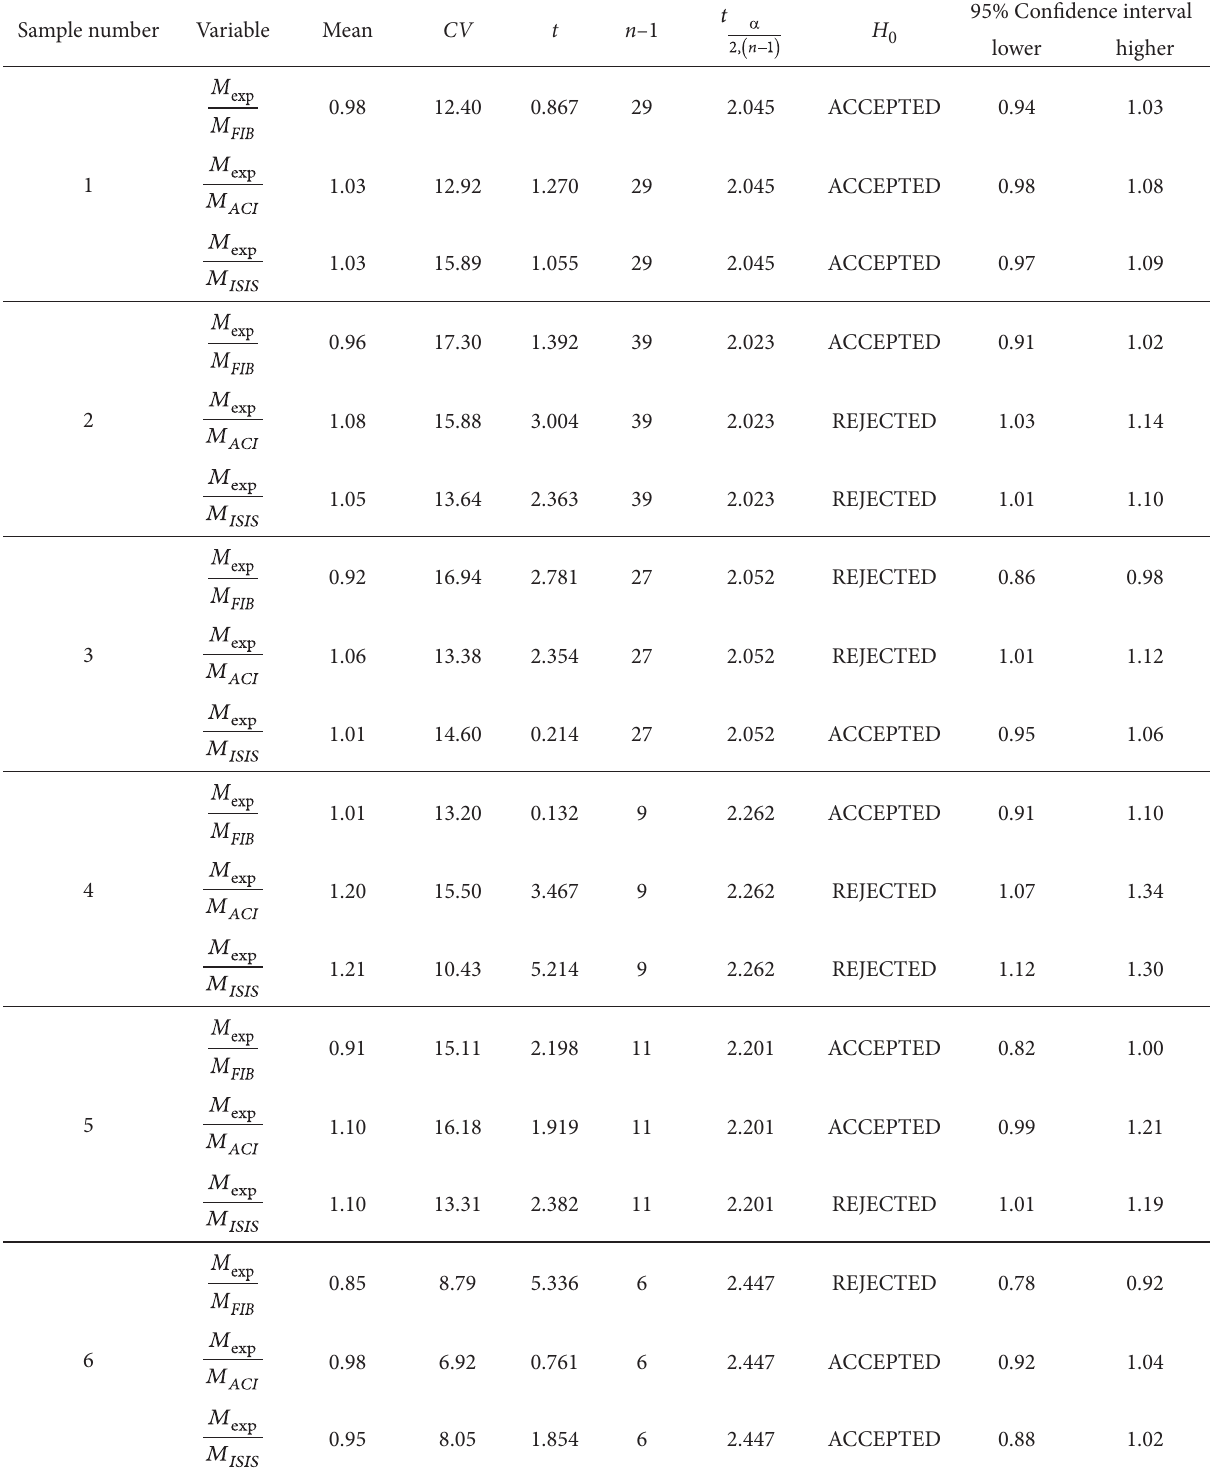
Table 3. Results of hypothesis testing Sample